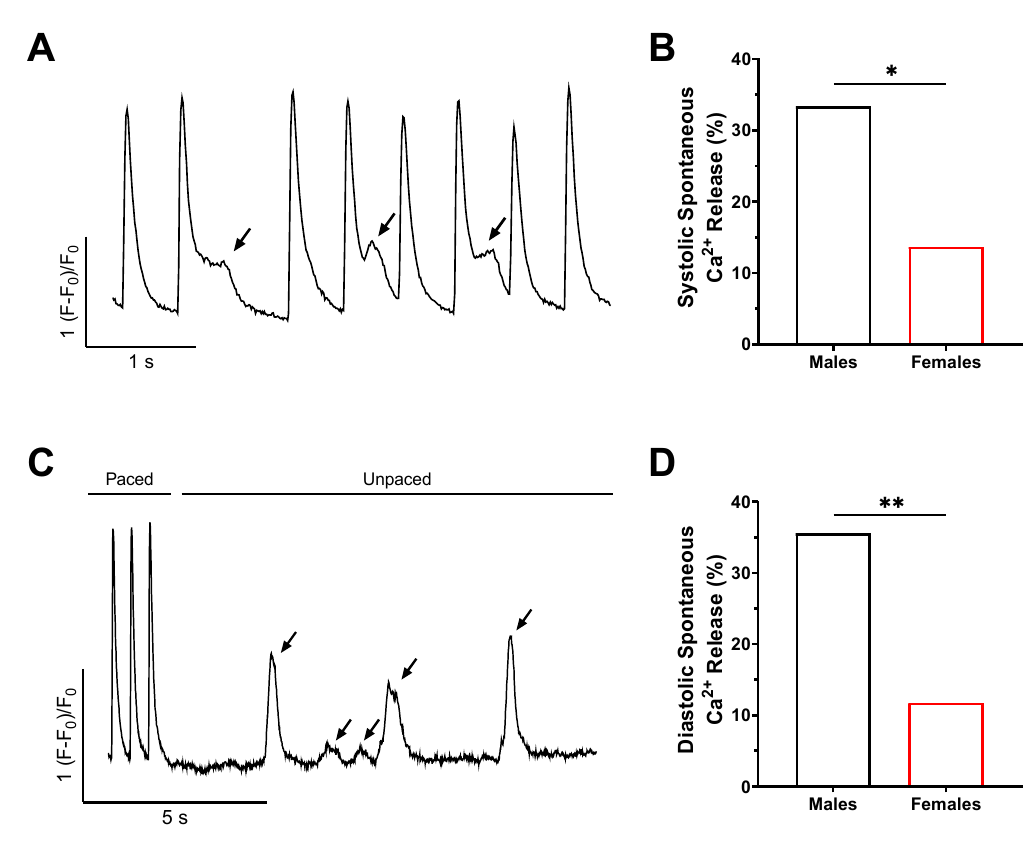
Figure 3. Spontaneous Ca 2+ releases are more frequent in male atrial myocytes. ( A ) Typical exam- ple of a Ca 2+ transient recording on a freshly isolated atrial myocyte exhibiting systolic spontaneous Ca 2+ releases during the 10 s of 2 Hz pacing. Events are highlighted by the arrows. ( B ) Percentage of cells in which systolic spontaneous Ca 2+ releases were observed (M: 33%, 20/60, N = 3; F: 14%, 7/51, N = 3; * p = 0.02, two-sided chi-squared test). ( C ) Typical example of a recording showing spontane- ous Ca 2+ releases during diastole, during the 10 s without pacing. Events are highlighted by the arrows. ( D ) Percentage of cells in which diastolic spontaneous Ca 2+ releases were observed (M: 36%, 21/59, N = 3; F: 12%, 6/51, N = 3; ** p = 0.004, two-sided chi-squared test).